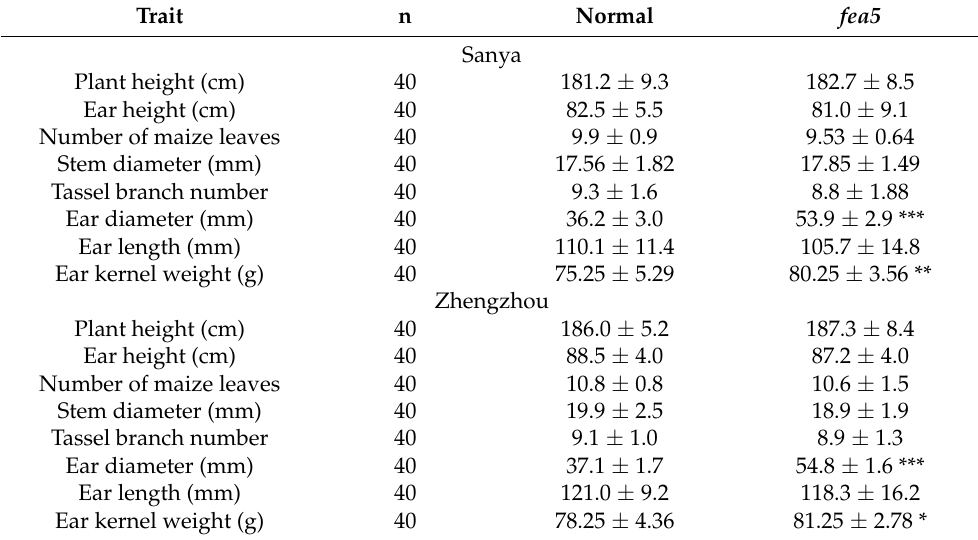
Figure 1. Phenotypes of fea5 mutants. ( A ) The height of fea5 mutants is similar to that of normal plants. Bar = 30 cm. ( B ) The tassel of fea5 is similar to that of normal plants. Bar = 5 cm. ( C ) The tassel of fea5 is similar to that of normal plants. Bar = 5 cm. ( D ) fea5 ears were massively fasciated compared with normal ears and had disorganized rows. Bar = 20 mm. ( E ) Cross section of fea5 ears. Bar = 10 mm. Table 1. Agronomic traits of fea5.